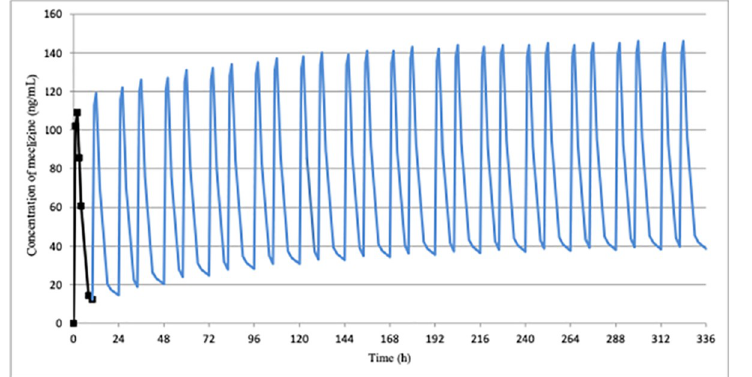
Fig 5. Simulated plasma concentration profile of meclizine at twice a day for 14 days multiple administrations in ACH children. Plasma concentration simulated using the mean measured results after once a day administration of meclizine hydrochloride 25 mg tablet (body weight normalized) also reached steady state around 10 days after the first dose.